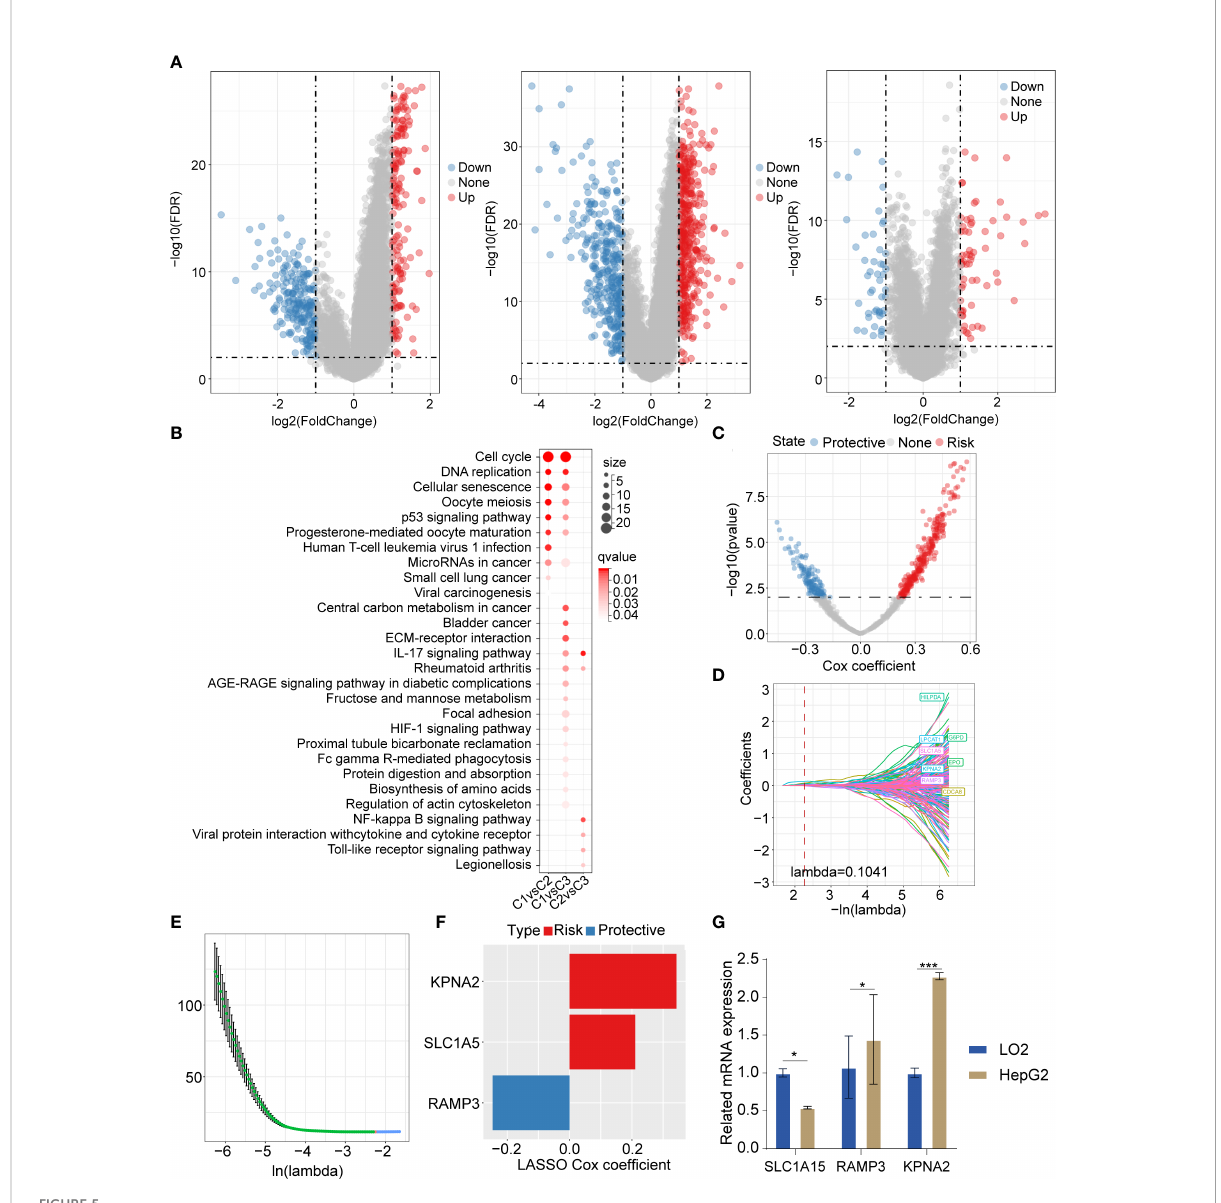
FIGURE 5 The DEGs and their enriched signaling pathways between 3 clusters, and DEG-based prognostic model construction (A) Volcano plot of DEGs between C1 vs C2, C1 vs C3, and C2 vs C3. (B) The upregulated DEGs based enriched signaling pathways in 3 clusters. (C) The volcano plot showed promising candidates among DEGs between 3 clusters. (D) The trajectory of each independent variable with the change of lambda. (E) The con fi dence interval varying under lambda. (F) The LASSO cox regression identi fi ed 3 necroptosis-related gene signatures. (G) The qPCR results showed that the 3 necroptosis-related genes were differently expressed in LO2 and HepG2. The LO2 cell lines and HepG2 cell line were obtained from ATCC (https://www.atcc.org/). *P<0.05;